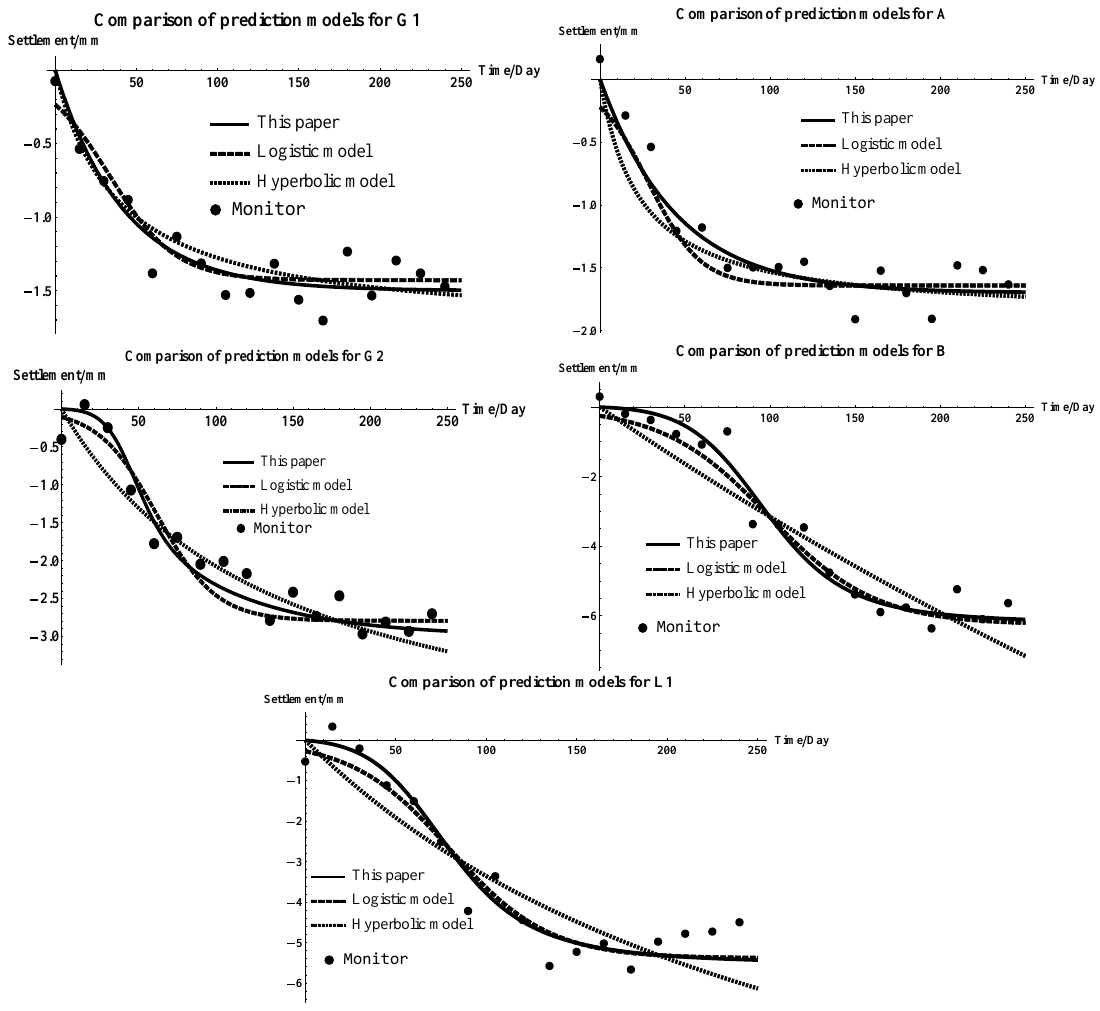
Figure 11. Settlement–time curve for ground settlement.